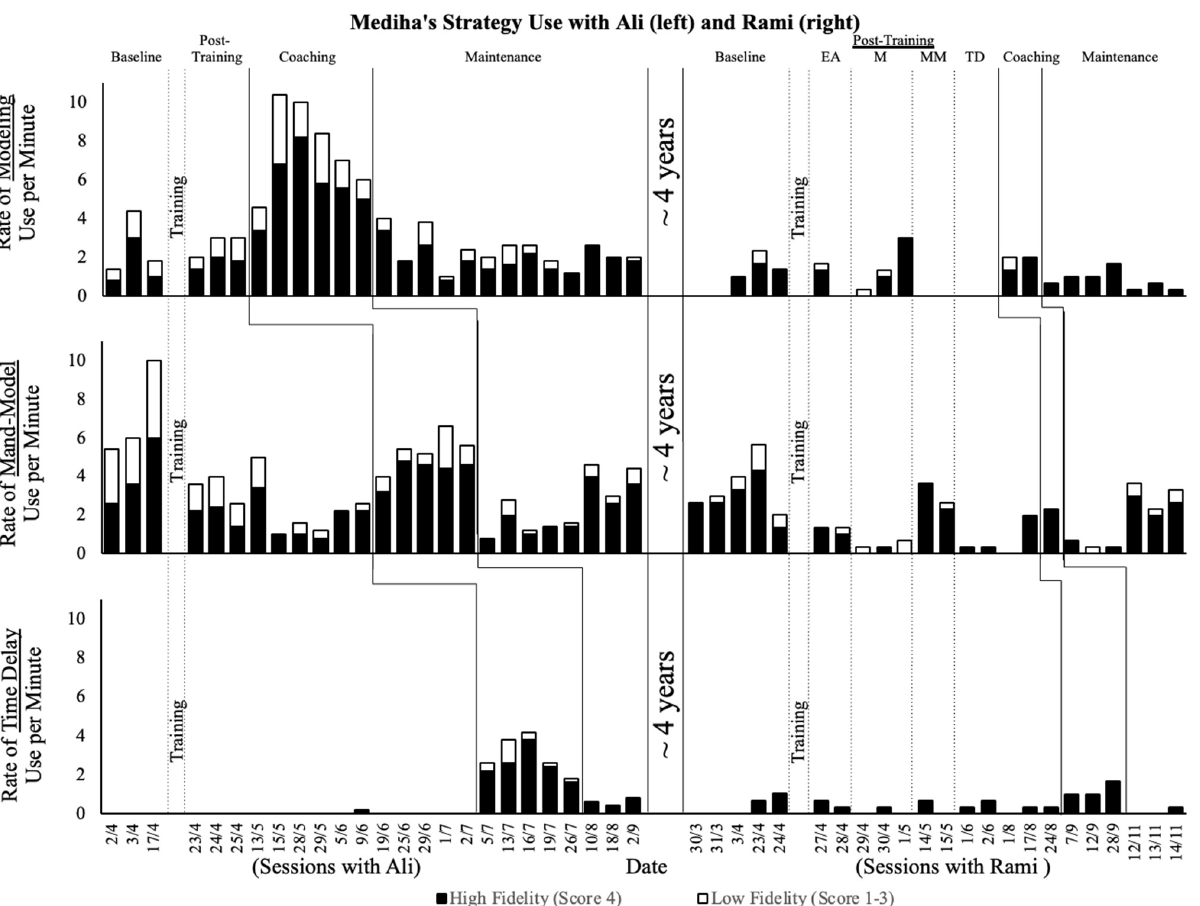
Figure 1. Mediha’s observed behavioral data with the approximate 4-year gap between studies marked with two vertical lines and labeled. Each tier of the graph represents one strategy, with modeling on the top tier, the mand-model on the middle tier, and time delay on the bottom tier. The height of the bars represents the rate per minute of strategy use during the session. Black portions of each bar represent high-fidelity strategy use and white portions represent low-fidelity strategy use.